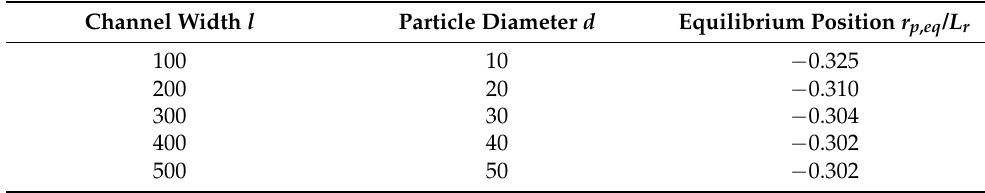
Figure 7. Relationships between the equilibrium position of the particle and the resolution at inner wall side for 𝑅𝑒 = 64 and 𝐶 = 0.10 . Table 4. Value of equilibrium position of particle at each number of grids of channel width and particle diameter at inner wall side for 𝑅𝑒 = 64 and 𝐶 = 0.10 .